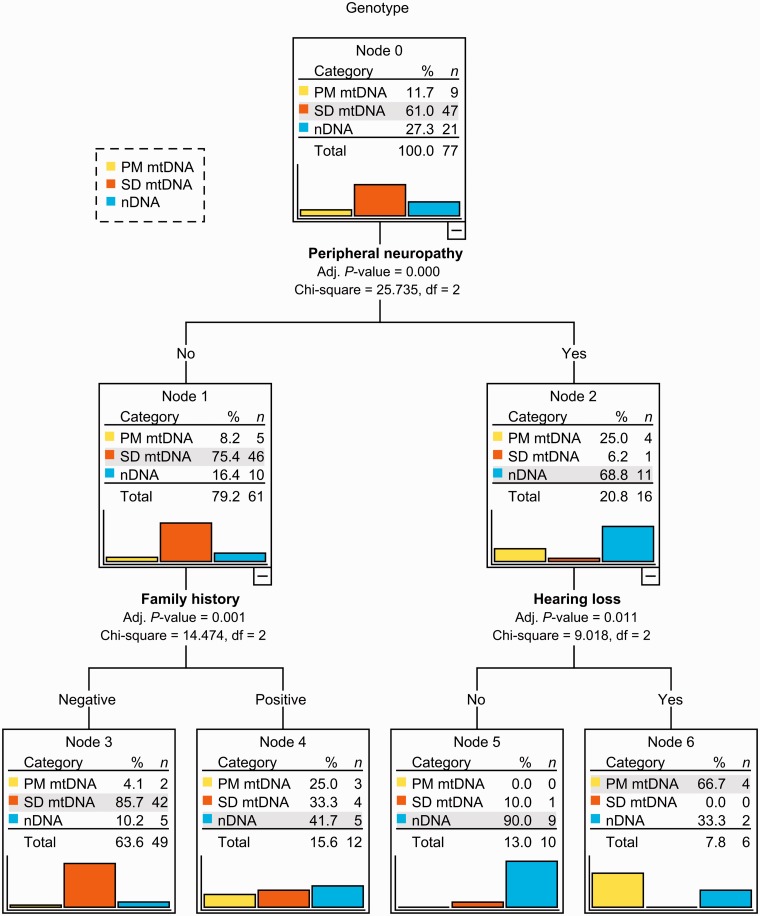
Ten-fold cross-validated, exhaustive Chi-squared automatic interaction decision tree for classification of genotypes according to individual clinical features (n = 77). Percentages and bars for each genotype (category) indicate the relative proportion of patients within each node. Total percentages represent the proportion of patients in each node relative to the initial sample. Adj. P-value = adjusted P-value; df = degrees of freedom; nDNA = nuclear DNA defect; PM mtDNA = point mutation of mitochondrial DNA; SD mtDNA = single mitochondrial DNA deletion.